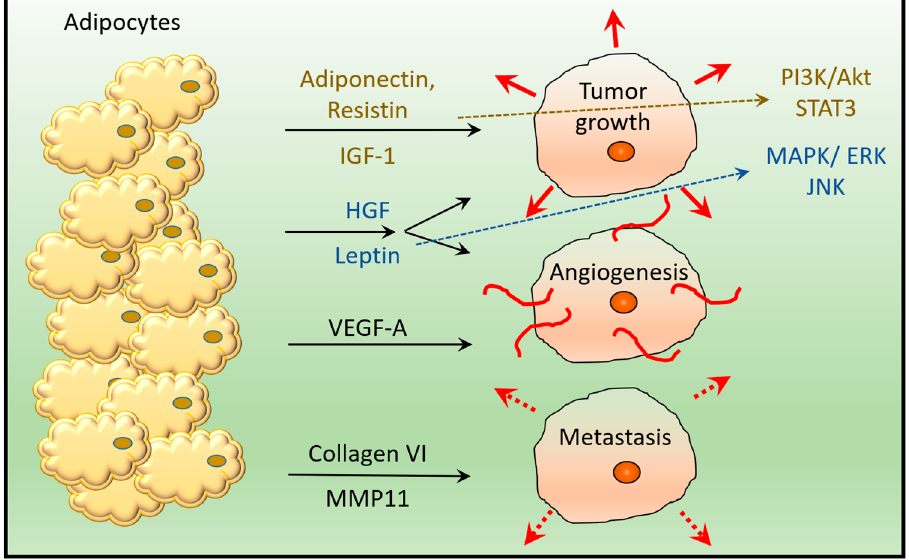
Figure 2. Compounds secreted by adipocytes support tumor growth, angiogenesis and metastasis. Adipocyte-secreted adiponectin, resistin, IGF-1 (insulin-like growth factor 1), and HGF (hepatocyte growth factor) induce tumor growth via activation of the PI3K/Akt (phosphoinositide 3-kinase/pro- tein kinase B) and STAT3 (signal transducer and activator of transcription protein 3) pathway. IGF- 1 and HGF also activate the MAPK/ERK (mitogen-activated protein kinase/extracellular signal-reg- ulated kinase) pathway, together with leptin. HGF, Leptin and VEGF-A (vascular endothelial growth factor A) are involved in angiogenesis, while secreted collagen VI and MMP11 (matrix met- alloproteinase 11) play a role in tumor metastasis.